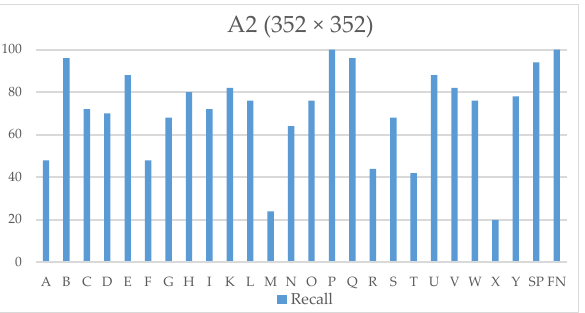
Figure 11. Sign language recognition (SLR) system signs detection recall using testset. Recall was calculated using: Recall(n) = TP(n)/(TP(n) + FN(n)), 26 ≥ n ≥ 1 , (3) where TP is true positive, and FN is false-negative. The mean recall of YOLO model A2 (352 × 352) is 71.23%, which was calculated using: Mean recall = ∑ n = 1..26 Recall(n)/26, (4) To better understand the performance of A2 (352 × 352), Figure 12 shows a confusion matrix of the selected YOLO model. The confusion matrix was generated with 50 images per sign (testing set). In Figure 12, rows and columns represent target and predictions, respectively; N/D is not detected. As can be seen in the confusion matrix, where false pos- itives (FP) and false negatives (FN) are shown; signs, such as “X”, “M”, and “F” presents the highest FN, as above-mentioned, overfitting, and sign deformation during image rescaling can explain these misclassifications, and signs with the most similarities, such as, “N”, and “T” presents the higher FP. A SP FN N/D Figure 12. YOLO model A2 (352 × 352) confusion matrix. 3.2. Bidirectional LSTM Results The RNN was trained to correct words within an own generated dictionary. The dic- tionary consists of 235 English sentences, which are of common use on a daily basis. A sample is presented in Table 3. Resulting in a training accuracy of 98.07%. Table 3. Recurrent Neural Network (RNN) training dataset sample.